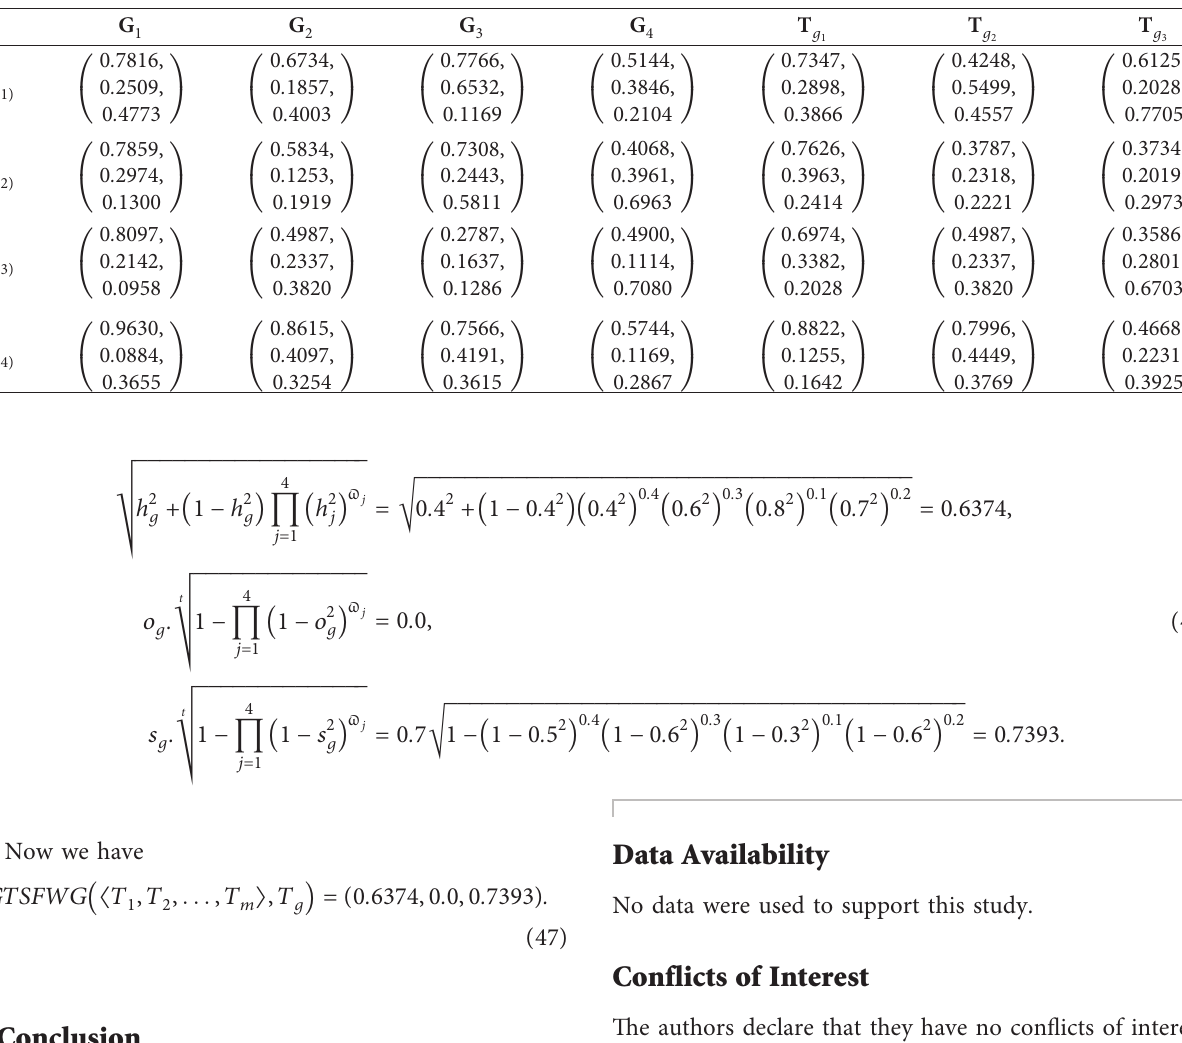
Table 7: Ordered aggregated